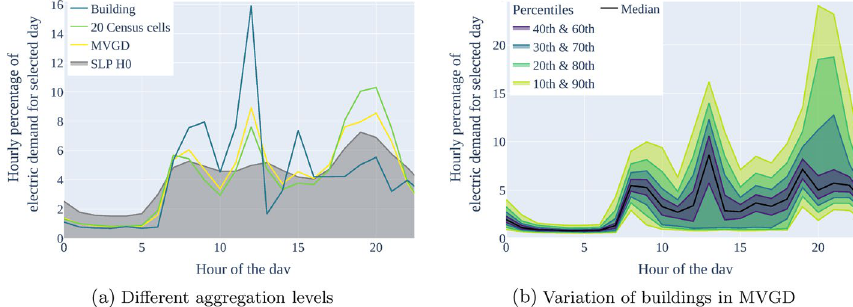
Fig. 4 Electricity demand time series and variation on selected